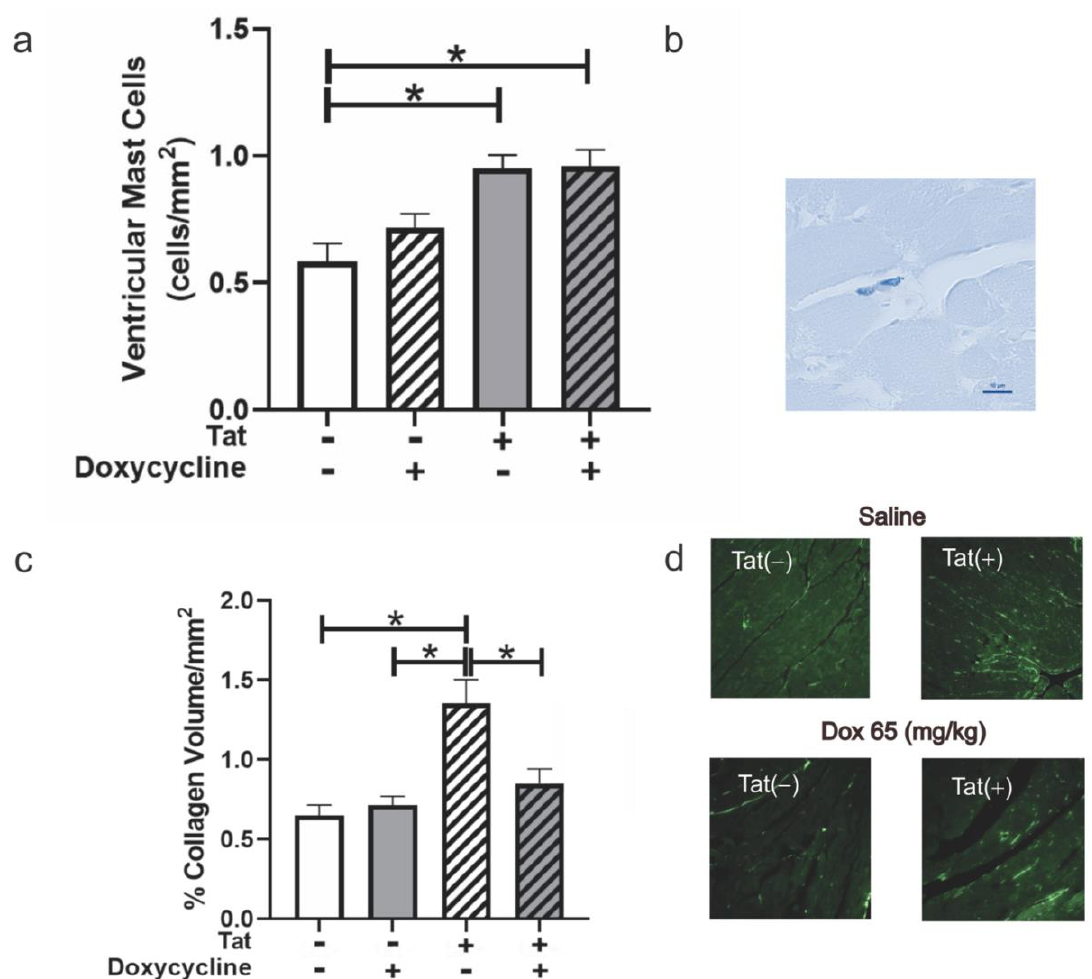
Figure 5. Mast Cells and Collagen Deposition in the Heart of Tat-Transgenic Adult Male Mice or their non-Tat-expressing counterparts. Tat expression influenced pro-inflammatory mast cell releases and extracellular collagen deposition in Tat(+) mice (n = 7–8/group). ( a ) Mast cell numbers and ( b ) a representative photomicrograph of stained mast cells. ( c ) Proportional collagen deposition and ( d ) PASR-stained representative images; * p ≤ 0.05; one-way ANOVA followed by Tukey’s HSD. Scale bar = 10 µ